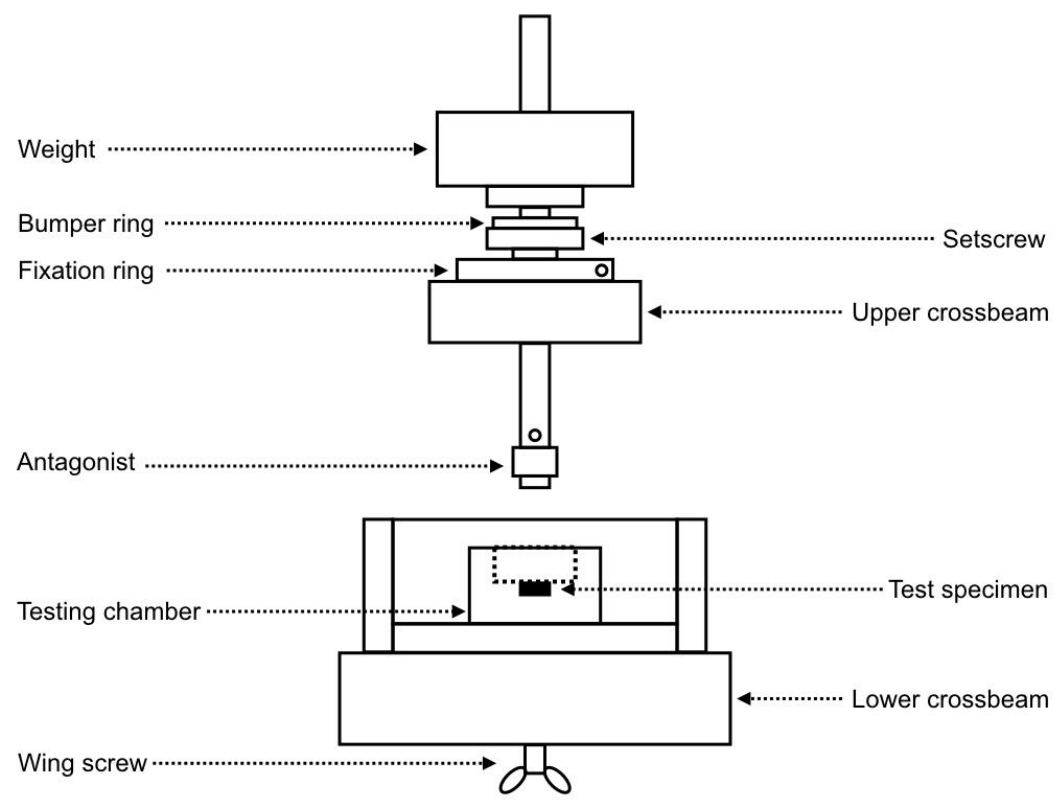
Figure 4. Schematic representation of the testing chamber of the CS-4.4 device.